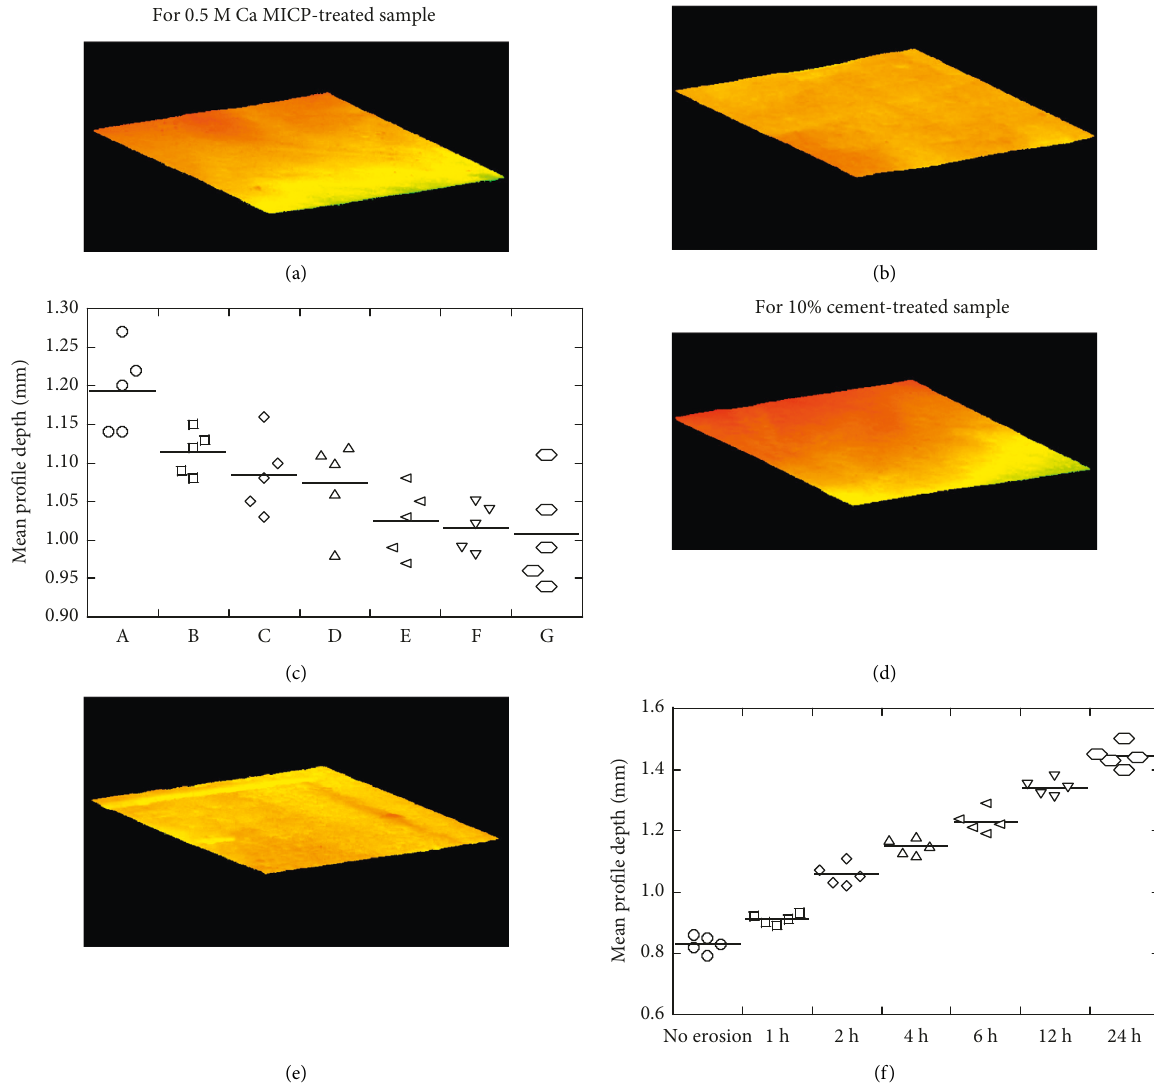
Figure 11: (a) and (c) 3D surface views of the sand surface before rainfall-induced erosion; (b) and (e) 3D surface views of sand surface after 24-h rainfall-induced erosion; (c) and (f) mean profile depth on the surface as a function of rainfall-induced eroded time. (a), (b), and (c) are for 0.5M Ca MICP-treated sample, whereas (d), (e), and (f) are for 10% cement-treated